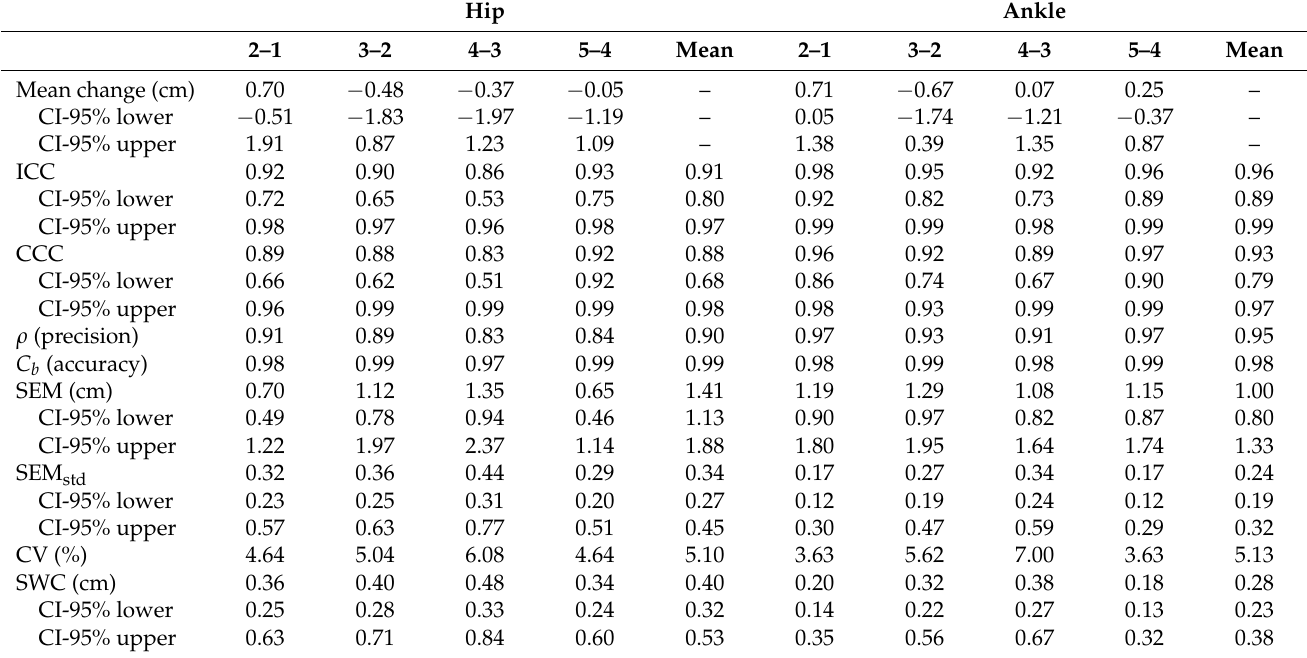
Table 3. Intra-session test–retest reliability (intra-session consistency) for hip and ankle